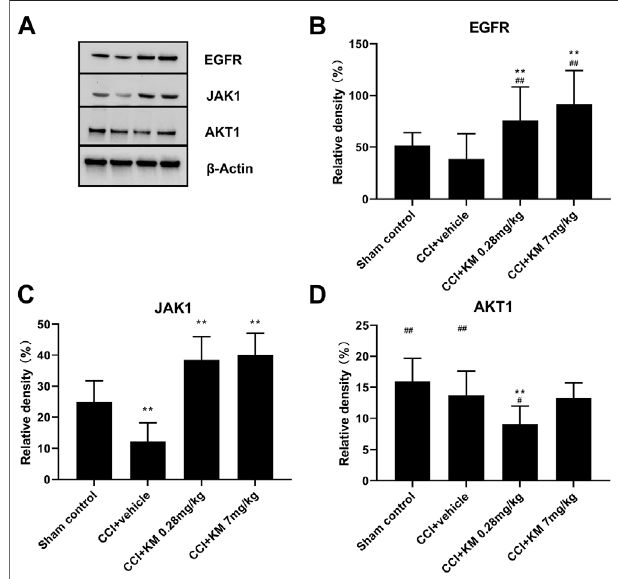
FIGURE 9 | Western blot (A) and relative protein expression of EGFR (B) ,JAK1 (C) ,andAKT1 (D) .Thedataarepresented asthemean ± SD(n (cid:2) 6) and were analyzed using two-way repeated analysis of variance (ANOVA) followed by Bonferroni ’ s post hoc test, ## p < 0.01 compared with the sham control group; ** p < 0.01 compared with the vehicle control group. KM, koumine.